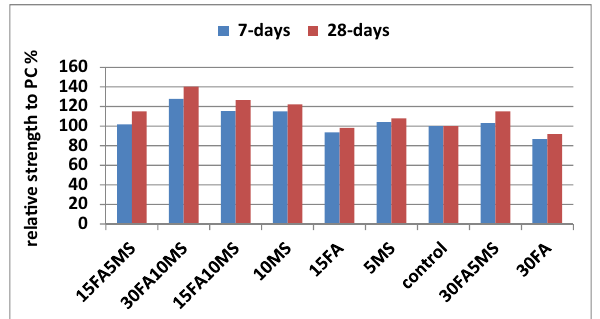
Figure 3: Relative strength of control concrete